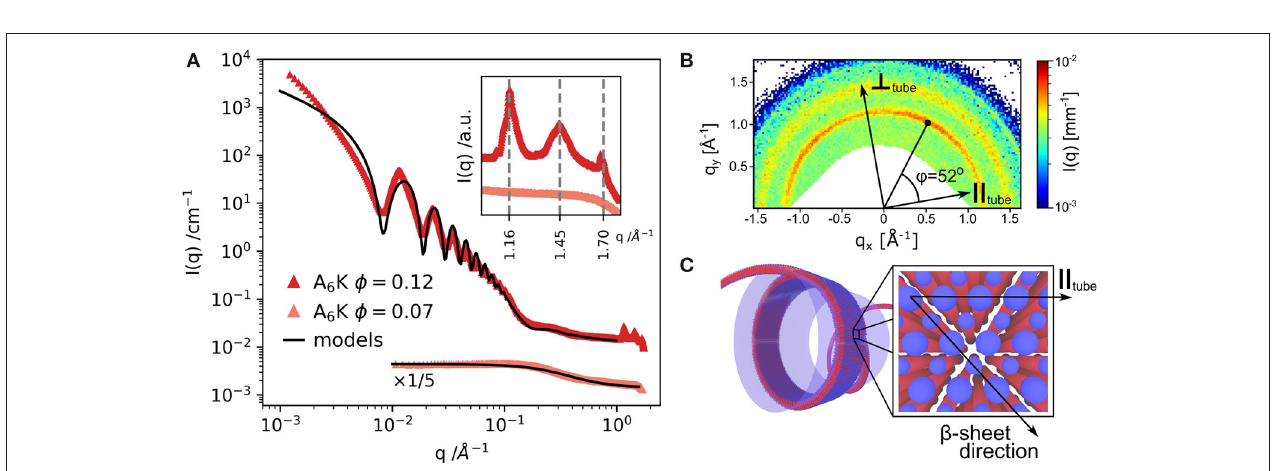
FIGURE 2 | (A) SAXS and WAXS (inset) profiles from A 6 K peptide for two concentrations above and below the peptide solubility limit. (B) WAXS pattern from partially aligned nanotubes showing the peptide packing and helical pitch angle of 52 o . (C) Model of the nanotube wall architecture: blue: hydrophilic peptide ends, red: hydrophobic core of the peptide sequence. Reproduced from Rüter et al. (2020) licensed under a Creative Commons Attribution 3.0 Unported License.